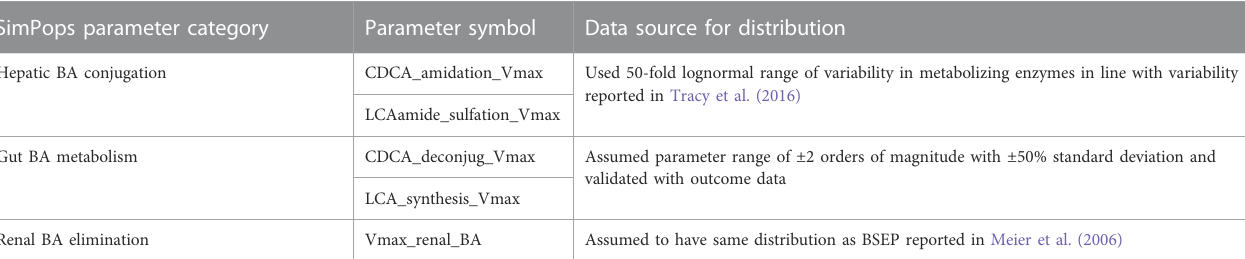
TABLE 1 ( Continued ) Bile Acid and Phospholipid Toxicity Mechanism Parameters with Distribution of Values for Virtual Subjects in the Human_ROS_apop_mito_BA_ chol_v1SimPops.ASBT,apicalsodium – BAtransporter;BA,bileacid;BSEP,bilesaltexportpump;CDCA,chenodeoxycholicacid;LCA,lithocholicacid;MDR3,multidrug resistance protein 3; PL, phospholipid; Vmax, maximum reaction